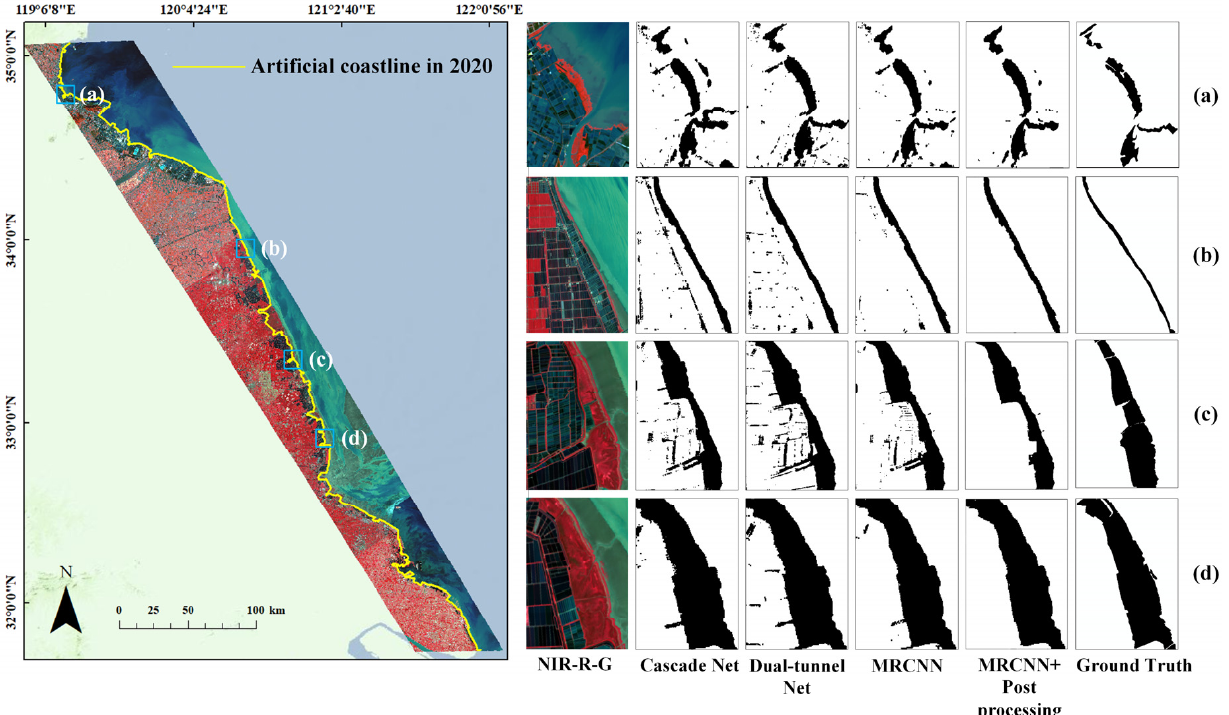
Figure 8. Classification results of S. alterniflora in typical regions in 2020. The yellow line is the artificial coastline of Jiangsu in 2020. ( a ) Linhong River Estuary. ( b ) Slender strip of S. alterniflora north of Sheyang River Estuary. ( c ) South of RCCNNR. ( d ) North of Dafeng Port Development Zone.